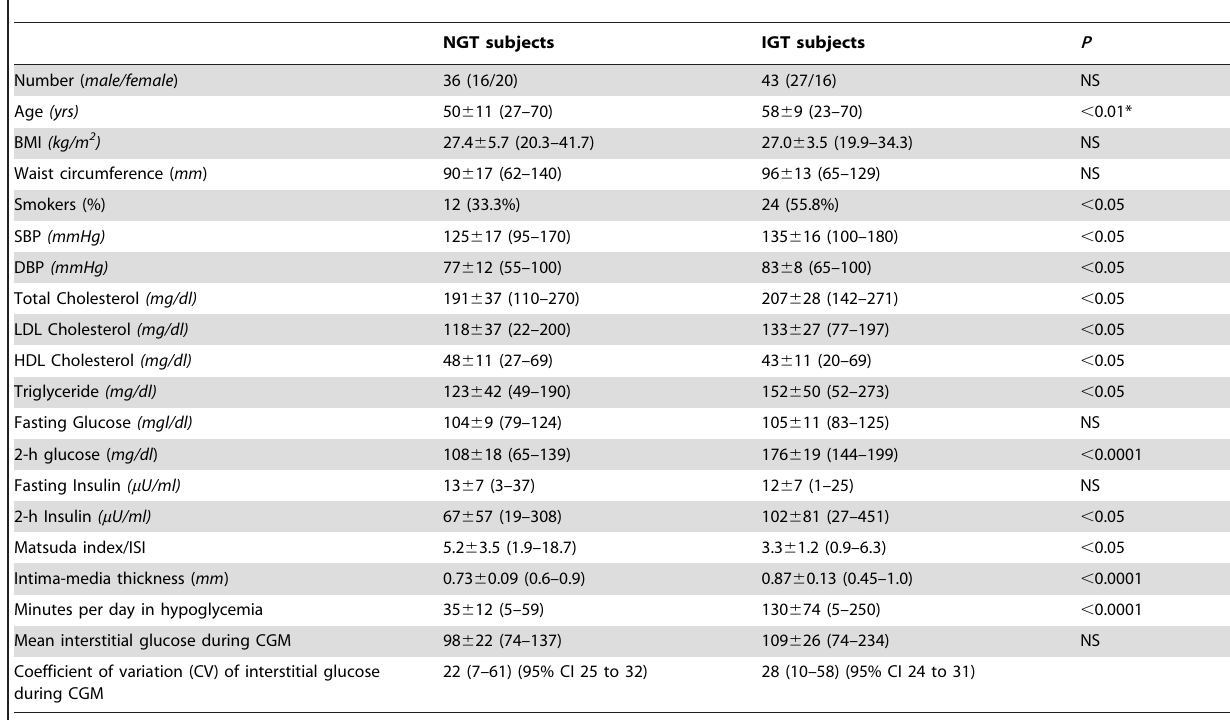
Table 1. Anthropometric and biochemical characteristics of the study